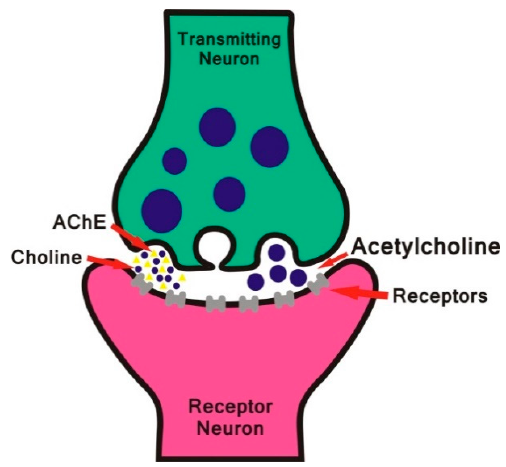
Figure 2. Representation of the acetylcholine (ACh) hydrolysis scheme.